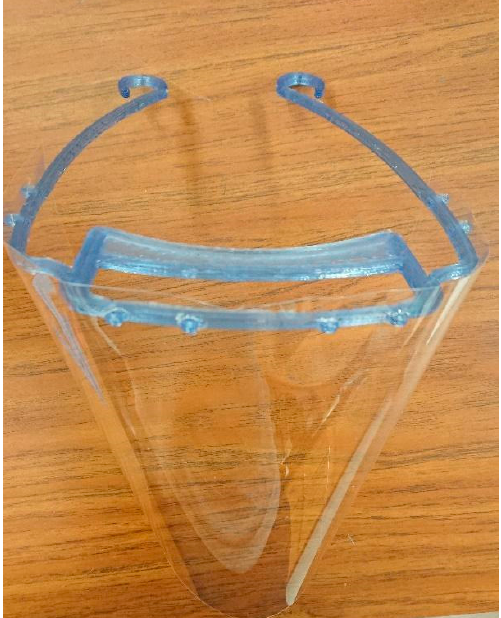
Figure 15. Recycled PET pellets used to 3D print a face shield.